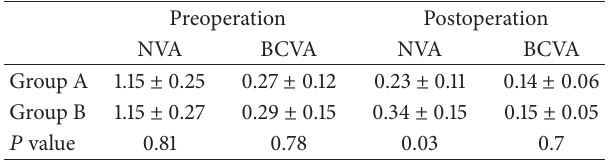
Table 3: Contrast sensitivity 3 months after